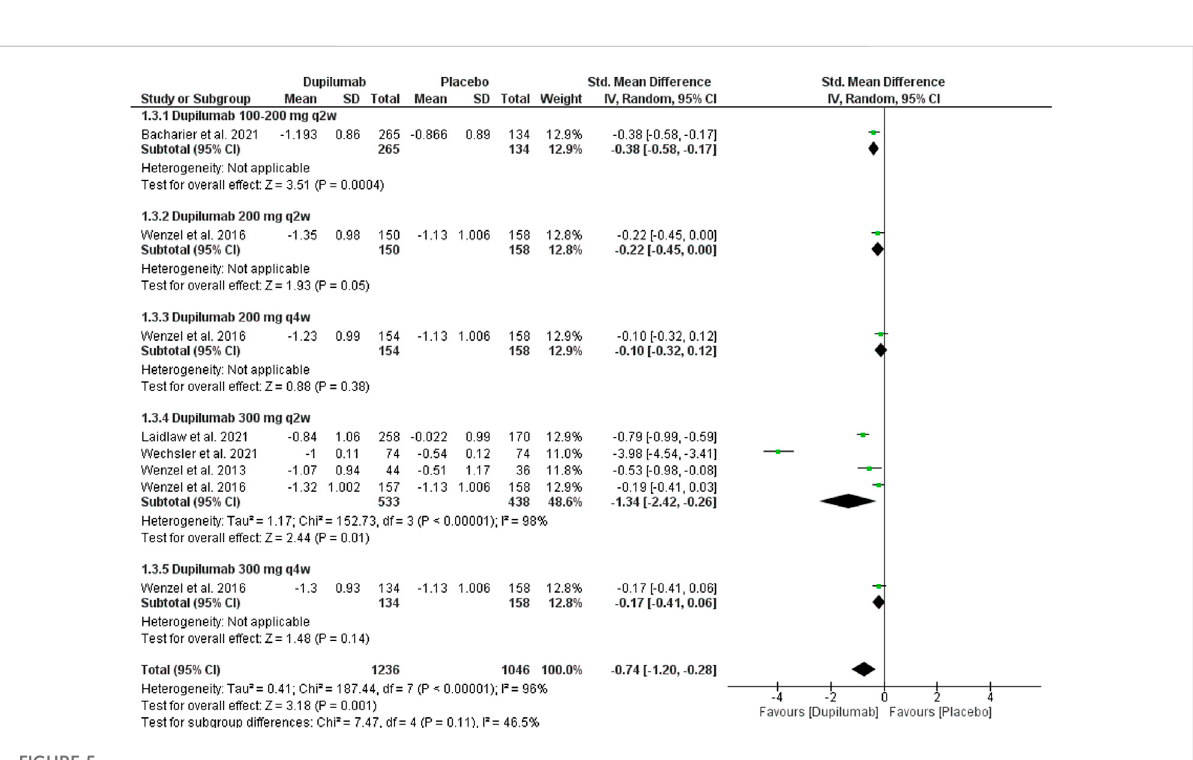
FIGURE 5 Results of the ACQ change at the 12th